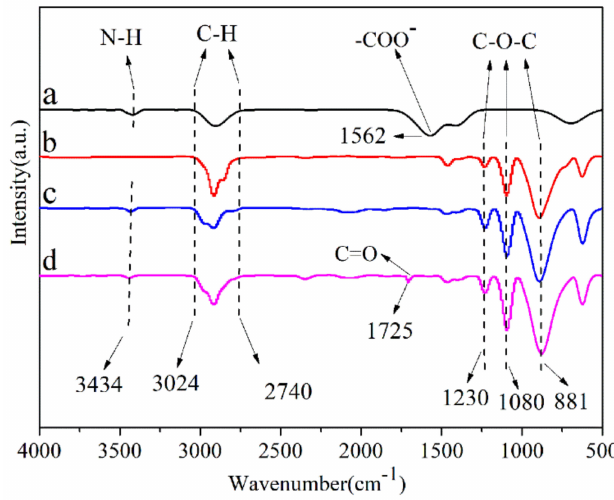
Figure 2. FTIR spectra of the ( a ) Ag nanoparticles, ( b ) POM, ( c ) POM/Ag nanocomposites, and ( d ) POM/Ag/MAH- g -POE